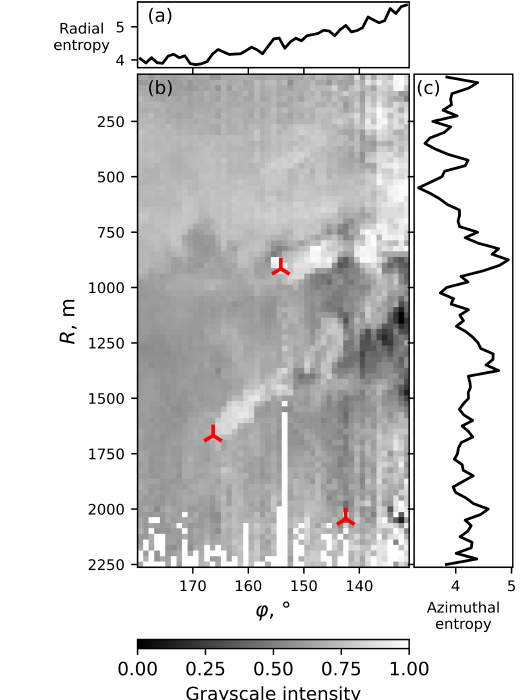
Figure 5. The entropy calculated in the (a) radial and (c) az- imuthal directions of (b) the lidar scan 61. Reference wind speed is 7.19ms − 1 and reference wind direction is 203.68 ◦